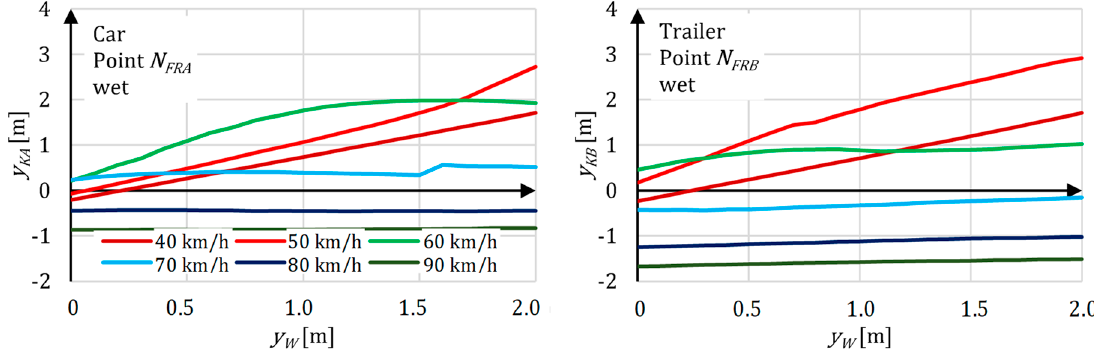
Figure 19. Curves representing selected physical quantities for the cosine trajectory planning method, 𝐿 (cid:3028) = 6 m, 𝑣 = 60 km/h, dry road surface, and three clearance margin values 𝑦 (cid:3024) (individual columns): ( A ) CT unit’s motion animation; ( B ) path planning trajectory 𝑦 (cid:3014) (𝑥) and vehicles center of mass trajectory 𝑦 (cid:3004)(cid:3046) (𝑥) ; ( C ) steering wheel angle 𝛿 (cid:3009) (𝑥) , yaw angle 𝜓 (cid:3002) (𝑥) , trailer drawbar turning angle ∆𝜓(𝑥) ; ( D ) tire sideslip angles for the rear axle of vehicles 𝛼 (cid:3046) (𝑥) ; ( E ) lateral acceler- ation of vehicles center of mass 𝑎 (cid:3052)(cid:3004)(cid:3046) (𝑥) .